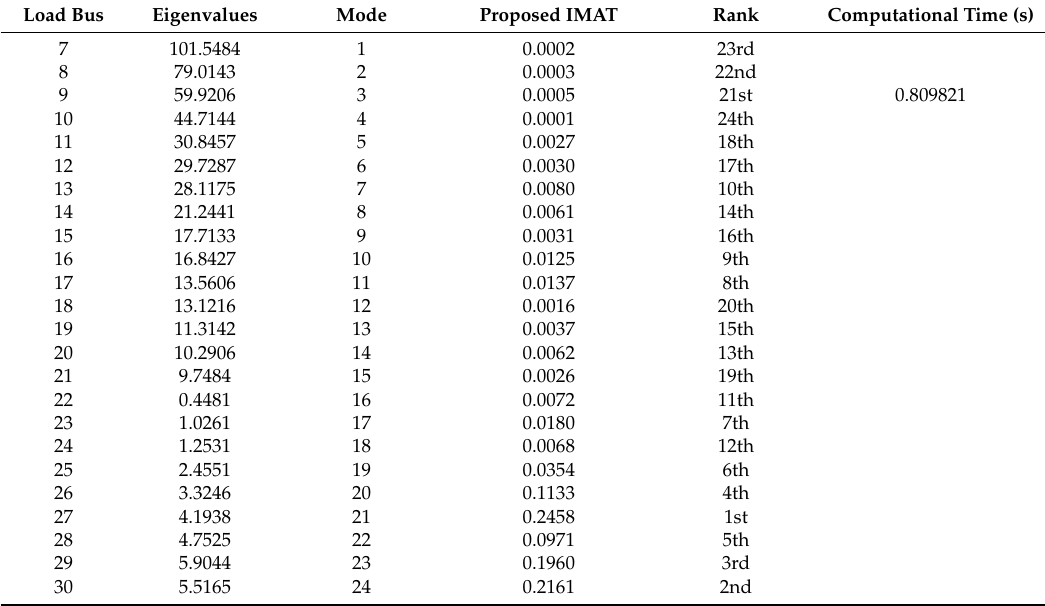
Table 8. Results of the suggested IMAT for the IEEE 30-bus power system.